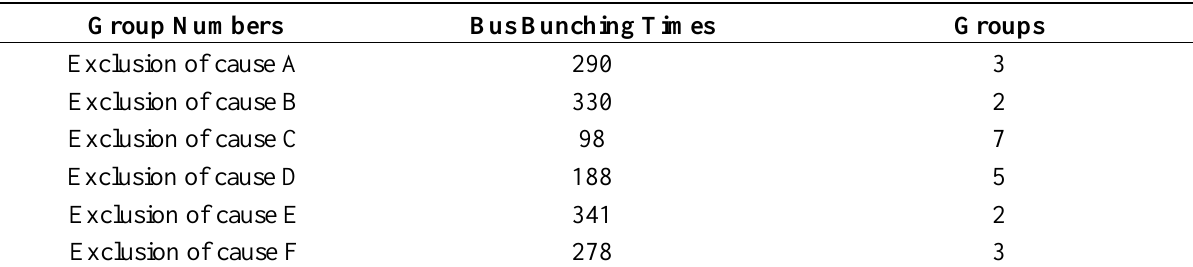
Table 8. The results of exclusive